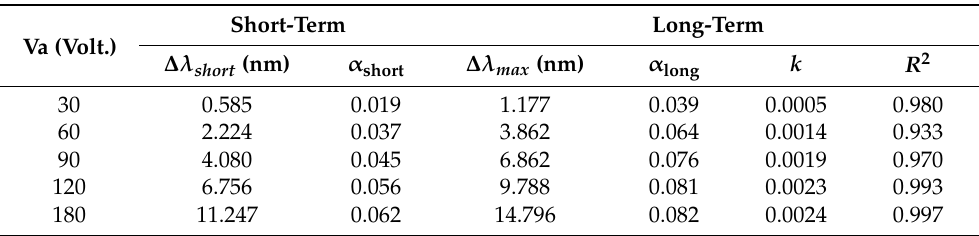
Table 1. Kinetics of short-term and long-term for applied voltages. Short-Term Long-Term Va (Volt.) ∆ λ short